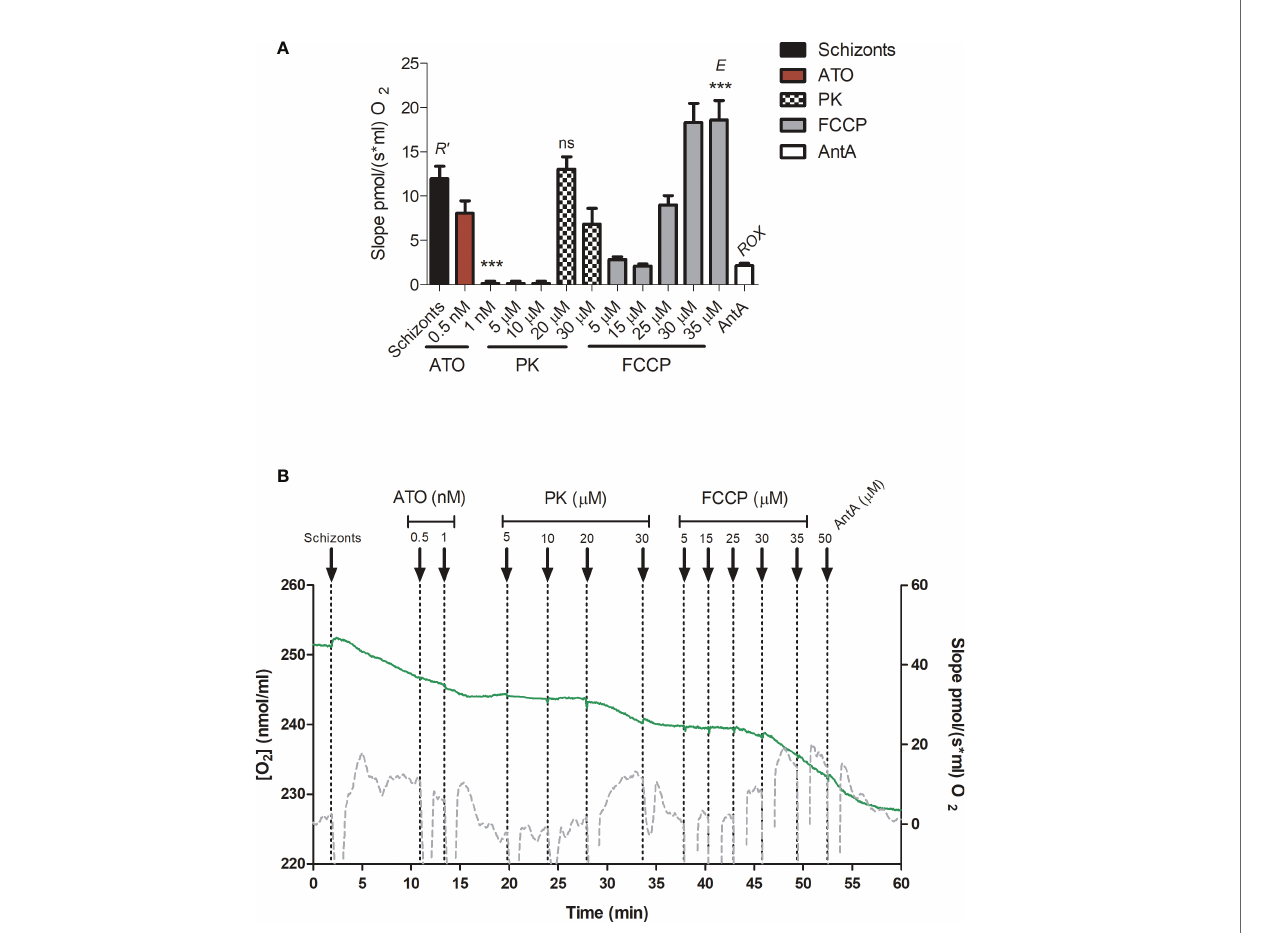
FIGURE 9 | Phylloquinone effect on respiration. Oxygen consumption was measured in erythrocyte-free schizonts. (A) The respiration slopes obtained under particular treatments are shown. R ’ , total cellular oxygen consumption. ATO, atovaquone 0.5 and 1 nM. PK: phylloquinone 5, 10, 20 and 30 µM. FCCP: carbonyl cyanide p-tri fl uoro-methoxyphenyl hydrazine (5, 15, 25, 30 and 35 µM. E , ET capacity. AntA, Antimycin A (50 µM). ROX, residual oxygen consumption, not related to R ’ . (B) Green lines represent the O 2 concentration in an oxygraph chamber as a function of time (left axis). The gray lines indicate the slope variation of oxygen concentration (right axis). As a positive control, the schizonts were maintained in respiratory buffer. One-way ANOVA followed by Dunnett ’ s posttest was used for statistical analysis to compare the values to R ’ . ***, p < 0.001; ns, difference not statistically signi fi cant. All experiments were performed three